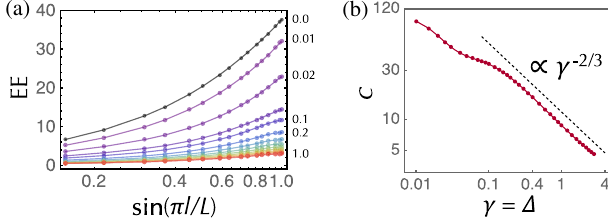
FIG. 12. Entanglement entropy of the symplectic Hatano- Nelson model with open boundaries ( J ¼ 1 . 0 ) at the critical point ( γ ¼ Δ ). The initial state is prepared as Eq. (24). (a) Entanglement entropy S ð L; l Þ ( L ¼ 100 ) for the steady state as a function of the subsystem length l for γ ¼ 0 . 0 , 0.01, 0.02, 0.05, 0.1, 0.2, 0.3, 0.4, 0.5, 0.6, 0.7, 0.8, 0.9, and 1.0. (b) Effective central charge c as a function of γ ¼ Δ ( L ¼ 100